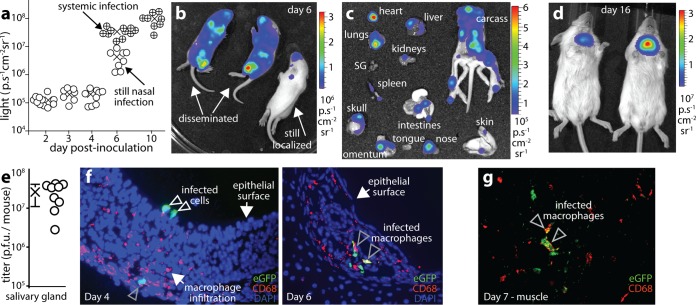
MCMV spreads from the nose to the salivary glands. (a) BALB/c pups given MCMV-LUC i.n. (3 × 104 PFU) were tracked by live imaging. On days 2 to 4, luciferase signals were only nasal; on day 6, some mice (circles containing + symbols) showed systemic infection spread and had significantly stronger signals than those with only nasal infection (open symbols) (P < 0.01); by day 10, infection had spread in all mice. The means are indicated by × symbols. The circles represent the values for individual mice. (b) Day 6 images show examples of localized and disseminated infections. (c) Dissection of a mouse with disseminated infection at day 6 shows involvement of multiple organs. The images shown are representative of the images for six mice. SG, salivary gland. (d) By day 16, live image signals were confined to the salivary gland. The images shown are representative of the images for 12 mice. (e) Salivary glands of mice given K181 MCMV i.n. (3 × 104 PFU) 1 month earlier were plaque assayed for infectious virus. The circles represent values for individual mice. The mean (×) ± standard error of the mean (SEM) (error bars) are shown. (f) At day 4 after i.n. inoculation of eGFP+ MCMV (3 × 104 PFU), the nasal (olfactory) epithelium showed CD68+ macrophage infiltration at sites of infection. The gray arrowhead indicates an infected CD68+ cell. At day 6 postinoculation, infected macrophages were more obvious and more widespread. The images shown are representative of the images for eight mice. (g) Pups were given MCMV-LUC i.n. (3 × 104 PFU). At the early stage of systemic spread (7 days postinoculation), luciferase-positive systemic sites were sectioned and stained to identify infected cells. Most were macrophages. The image shows a section of muscle from the chest wall. The image shown is representative of the images for six mice.